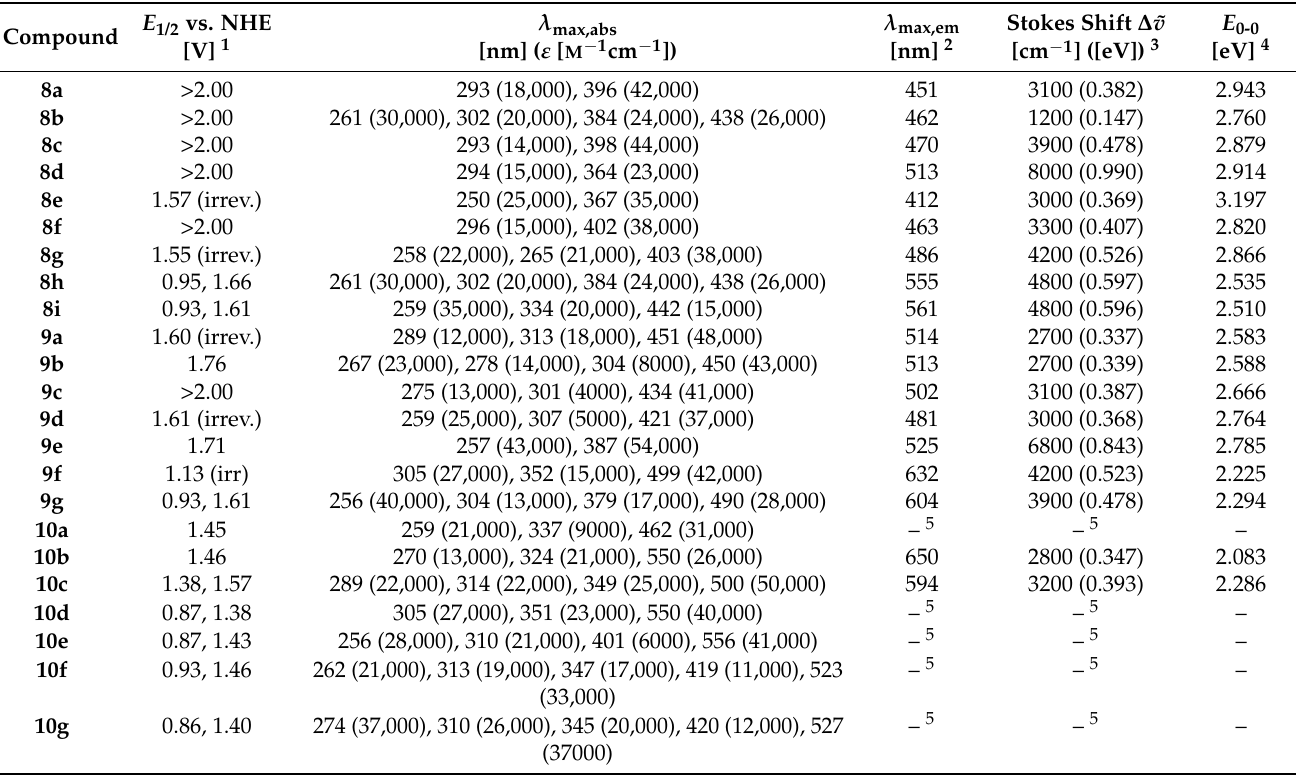
Table 1. Selected electronic properties of Merocyanines 8 – 12 (recorded in CH 2 Cl 2 , T = 298 K). E 1/2 vs. Compound